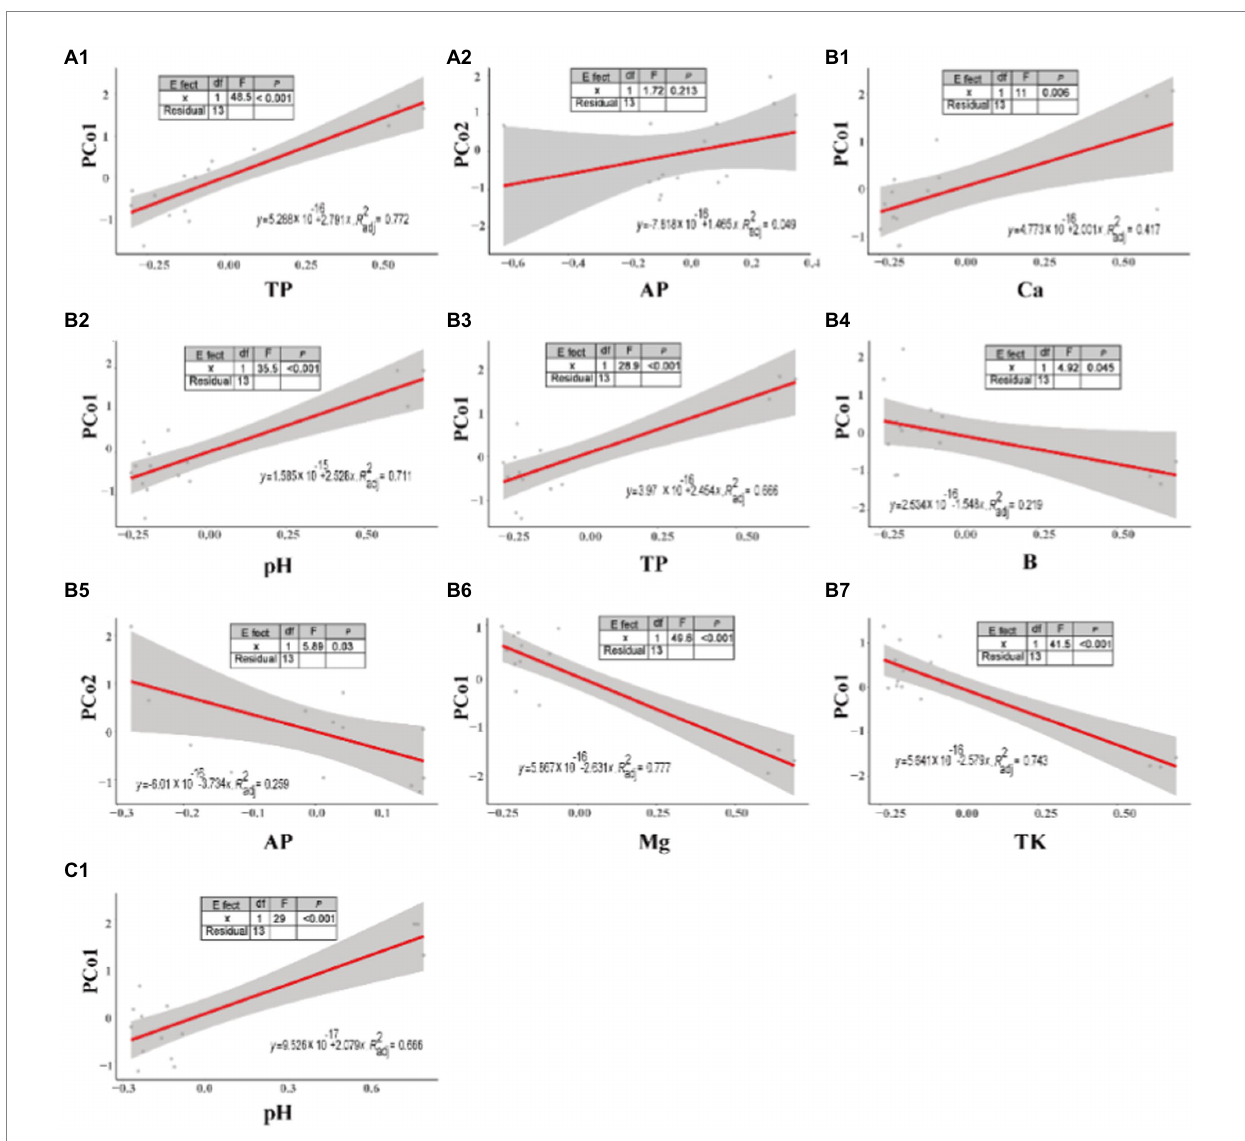
FIGURE 4 Linear regression between soil properties and microbial abundance at different slope positions. (A) bottom, (B) middle, and (C) top